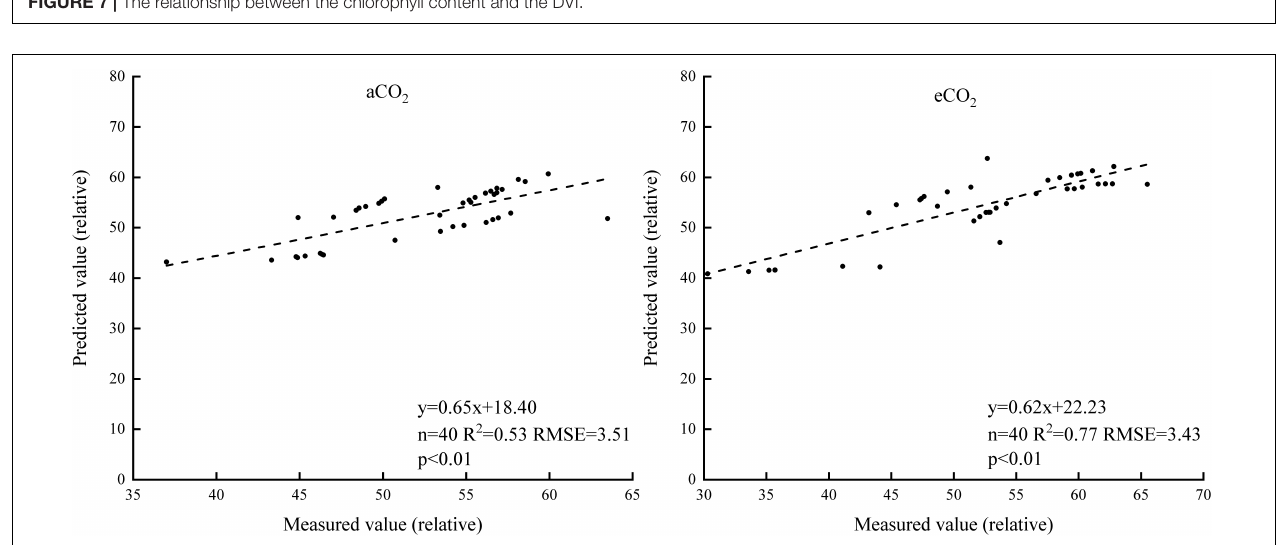
FIGURE 7 | The relationship between the chlorophyll content and the DVI.